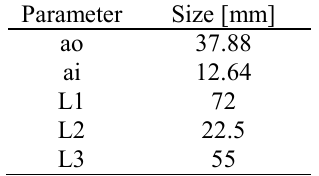
Table 1: Final dimensions of designed antenna.